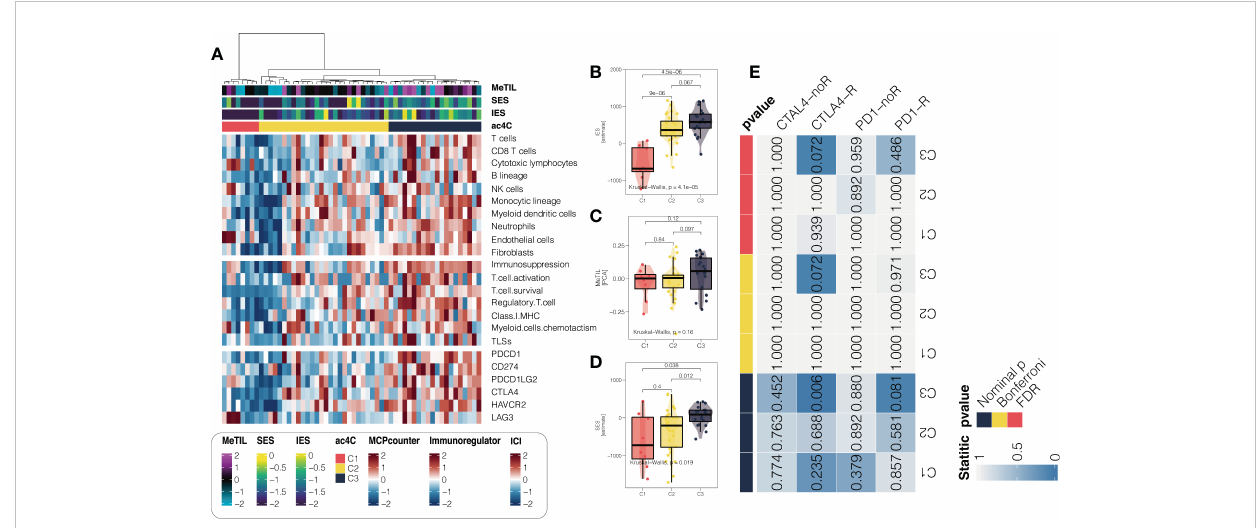
FIGURE 4 An analysis of the microenvironment of PDAC tumor subtypes associated with NAT10. (A) Heatmap showing the tumor microenvironment landscape in PDAC from the TCGA cohort, with the top panel showing the cell abundance estimated by MCPcounter algorithm, the middle panel showing the enrichment score of gene signatures for the functional orientation and the bottom panel showing expression of representative genes involved in immune checkpoint targets; the immune/stromal enrichment score and MeTIL score were annotated at the top of the heatmap. Distribution of immune enrichment scores, stromal enrichment scores and MeTIL scores among three NAT10-relevant subtypes in TCGA cohort were shown in (B) , (C, D) , respectively. (E) Subclass mapping demonstrating that the aggressive C3 subtype may be sensitive to immune checkpoint